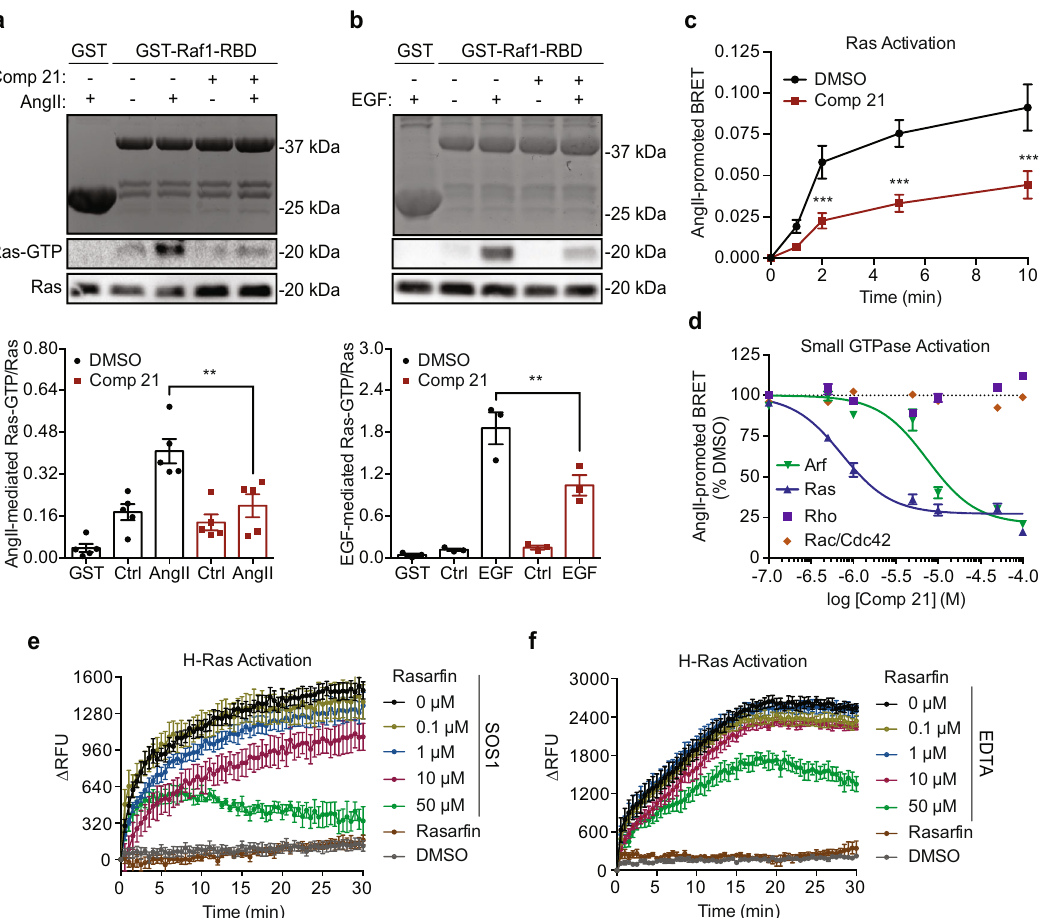
Fig. 4 Compound 21 targets Ras. a Coomassie of GST and GST-Raf1-RBD proteins and western blots of AT1R-mediated and b EGFR-mediated Ras activation in absence (DMSO, open black bars) or presence of 21 (50 μ M, open red bars) as assessed by GST- and GST-Raf1-RBD-coupled to glutathione beads pull-downs. Ras activation was calculated as the amount of Ras-GTP over the total Ras detected and are presented as mean values ± SEM, n = 5 for AT1R ( a ) and n = 3 for EGFR ( b ) biologically independent experiments, ** p < 0.001, one-way ANOVA with Bonferroni correction. c BRET kinetics of AT1R- mediated Ras activation in absence (DMSO, closed black circles and line) or presence of 21 (50 μ M, closed red squares and line). Data were quanti fi ed as AngII-promoted BRET and are presented as mean values ± SEM, n = 4 biologically independent experiments performed in triplicate, *** p < 0.005, two- tailed unpaired Student ’ s t -test. d BRET recording of the activation of Rho (purple squares), Rac (orange diamonds), ARF (green triangles and line) and Ras (blue triangles and line) by AT1R in the presence of 21 (50 μ M). BRET responses were quanti fi ed as AngII-promoted BRET, percent compared to DMSO (dotted line) and are presented as mean values ± SEM, n = 3 (Rho and ARF) and n = 4 (Rac and Ras) biologically independent experiments performed in triplicate. e , f In vitro kinetics of mant-GTP loading onto H-Ras. Puri fi ed H-Ras nucleotide exchange was induced using e puri fi ed SOS1 or f 40 mM EDTA in the presence of DMSO (black dots and lines) or different concentrations of Rasar fi n (as indicated with respective colors). The relative fl uorescence unit (RFU) was measured every 30 s for 30 min and quanti fi ed as the delta RFU (RFU post-addition minus the 5 averaged RFU pre-addition, per condition). Data are presented as mean values ± SEM, at least n = 4 biologically independent experiments. Source data are provided as a Source Data fi the Ras binding pocket. To support the position of the ligand pharmacophore interactions (Fig. 7a, b) that stabilize Rasar fi n inside the groove, we also simulated the spontaneous association binding in the Ras ’ effector binding interface between switch I of Rasar fi n to Ras. Five Rasar fi n molecules were randomly placed and II (Supplementary Video 1). The most discriminative features in the solvent around the open Ras (Fig. 5b) and simulated for a included the hydrophobic interactions (hereafter referred to as “ H ” groups) of the benzofuran (H1), the aryl (H2), the chloro- total of 6 μ s (3 × 2 μ s), yielding an average volumetric map of ligand positions (Fig. 5c). This map reveals that during sponta- atom (H3), the isopropyl moiety (H4), and the H-bond donor neous association, Rasar fi n favors the identi fi ed Ras groove as its (HBD) or H-bond acceptor (HBA) of the amide, which are the preferred binding site. To assess further the stability of Rasar fi n most detected combinations in the simulation. The benzofuran binding in the interface of Ras between switch I and II, we was most of the time stabilized by the hydrophobic interaction extended the simulation to a total time of 12 μ s (3 × 4 μ s). (H1) with Tyr40 or Leu56. The carbonyl oxygen of the backbone Monitoring the Root Mean Square Deviation (RMSD) of Rasar fi n of Ile55 is an acceptor for the HBD of Rasar fi n. The aryl ring with shows that Rasar fi n can stably bind to the predicted Ras binding the attached chloro-atom (H2) excessively interacts with Thr20, groove for microseconds (Fig. 6a, replica 1 for 1.5 μ s and the Tyr40, and Ile55 (Fig. 7b, c), while H3 (the chloro-atom) is kept whole 4 μ s of simulation in replica 2) but also unbinds at times in place and in close vicinity to Val8, Thr20, Ile24, Tyr40 and (Fig. 6a, end of replica 1 and replica 3). The computation of Ile55, most of the simulation time. The isopropyl (H4) was contact frequencies from simulation data highlights key mainly oriented toward switch II, in proximity to Ile21 (Fig. 7c).